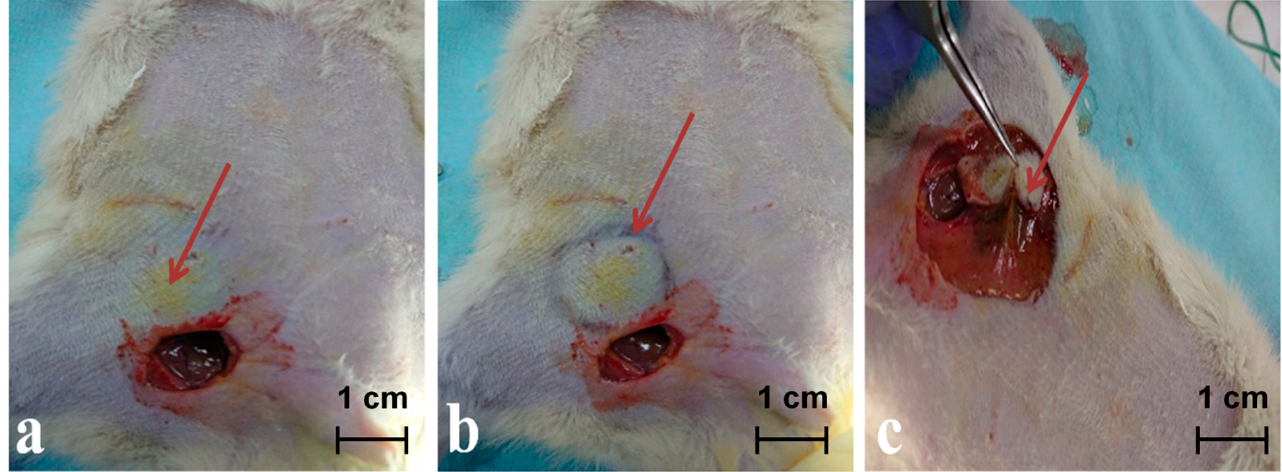
Figure 4. ( a ) Image of the functional perforasome marked by PRO intraoperatory. ( b ) Image with the margins/edges of the perforasome marked for better view. ( c ) Identification of coloured perforator.